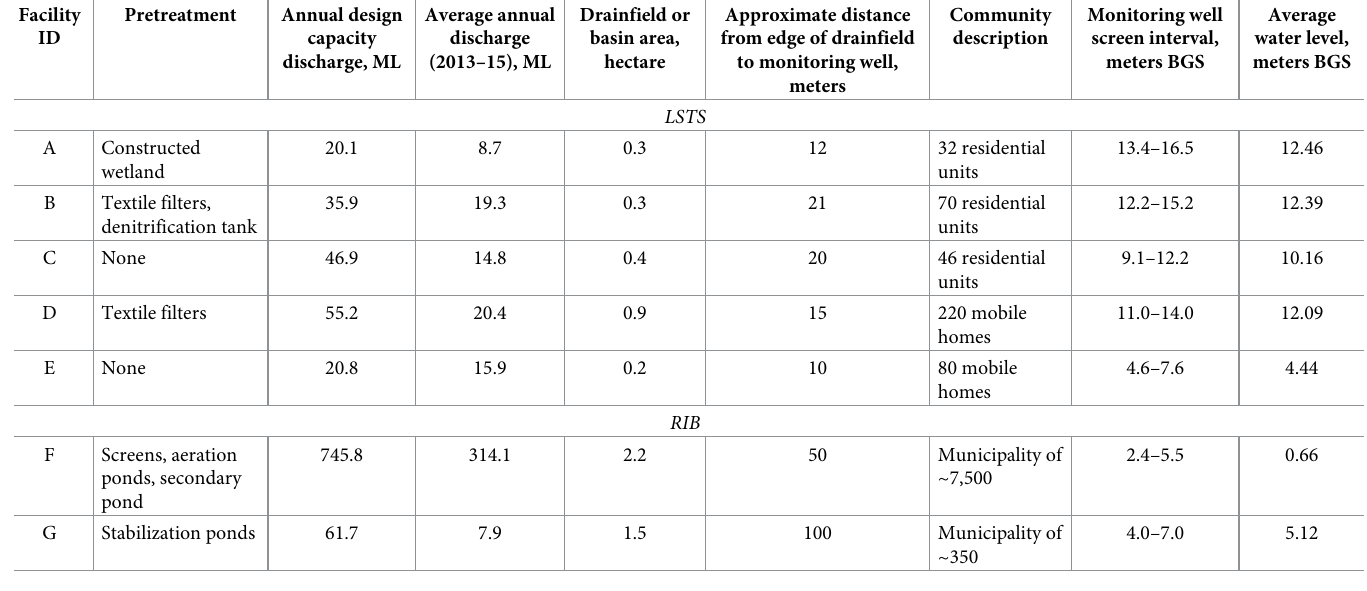
Table 1. Large subsurface treatment systems (LSTS) and rapid infiltration basins (RIB) where groundwater was collected and analyzed for micropollutants, 2014–